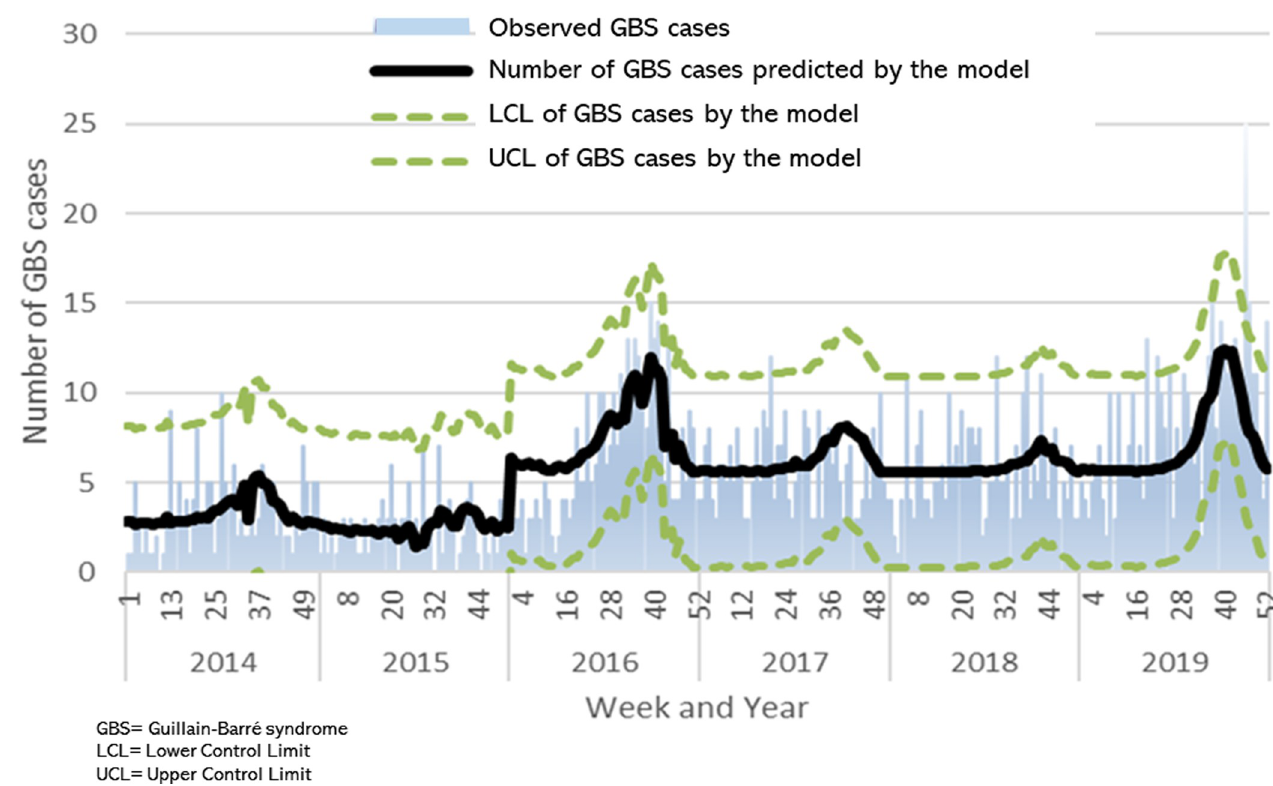
Fig 2. Epidemic curve of GBS model observed and predicted cases and arbovirus cases in Mexico, IMSS